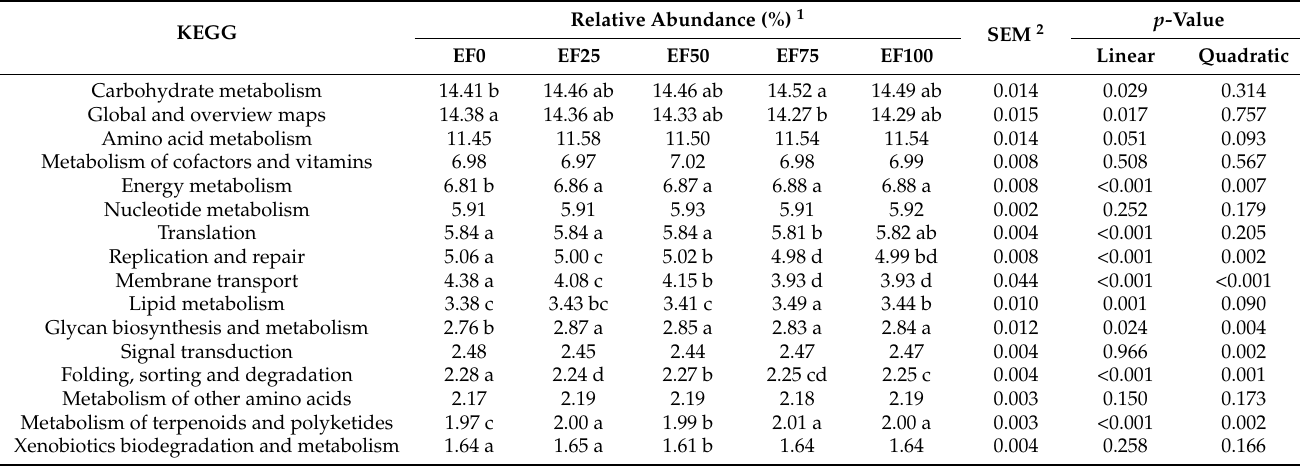
Different lowercase letters in a row of data indicate significant differences at p < 0.05 among different treatments. 1 EF0, EF25, EF50, EF75, and EF100 are defined as EF replacement ratios of 0%, 25%, 50%, 75%, and 100% of the fermentation substrate, respectively. 2 SEM, standard